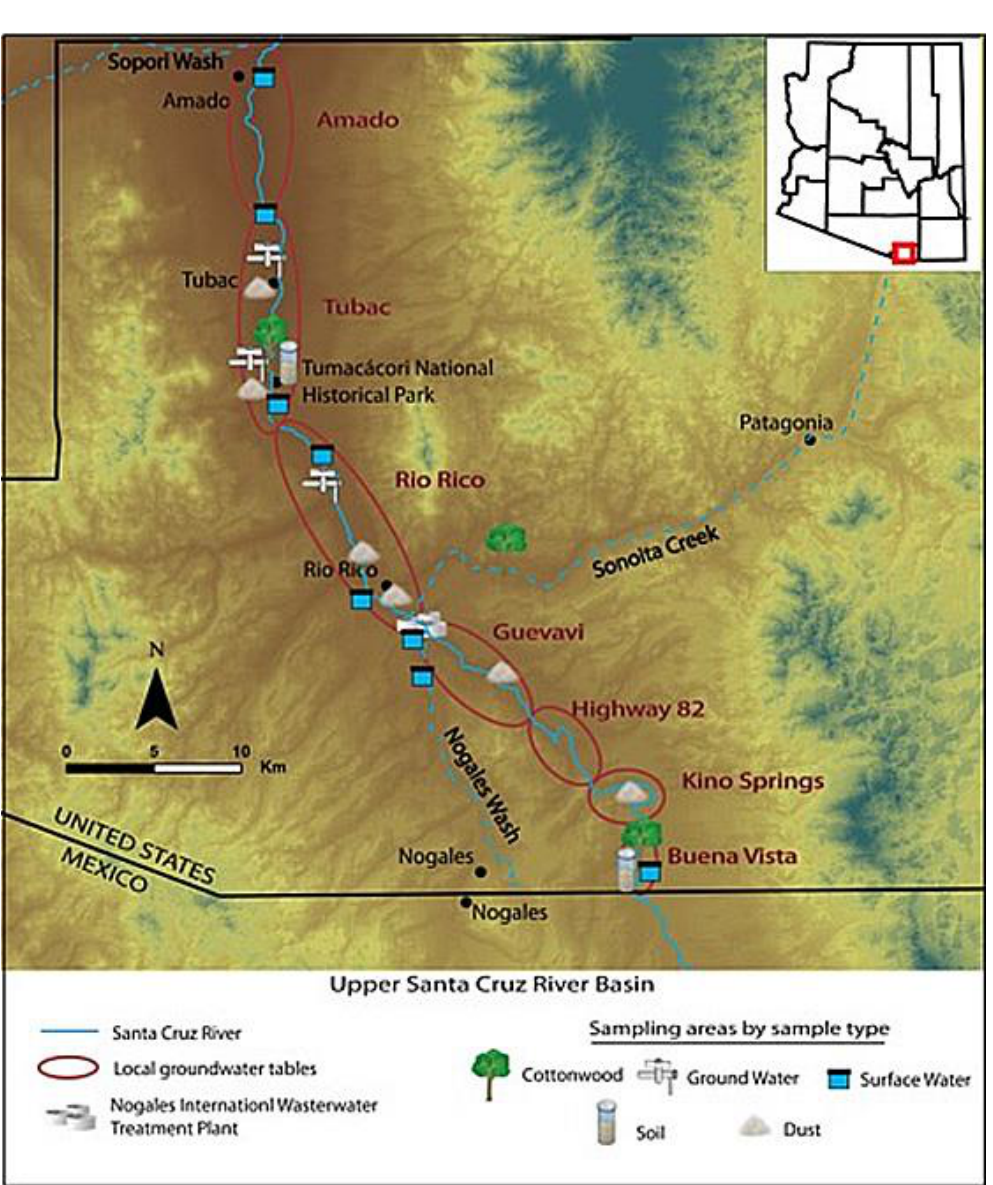
Figure 1. Upper Santa Cruz River Basin sampling locations and types.